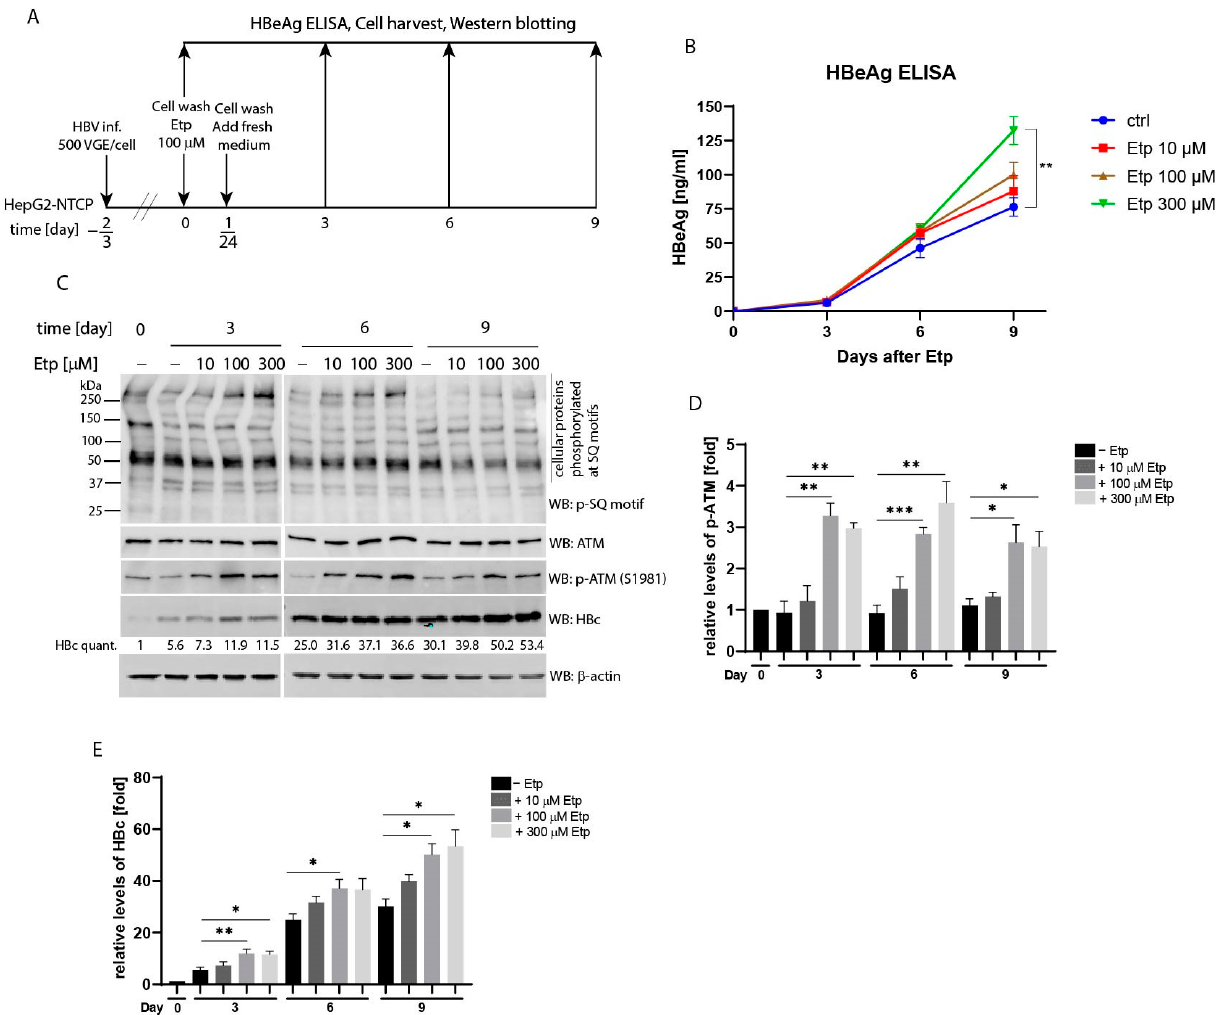
Figure 6. The stimulatory effect of etoposide treatment on the level of HBeAg and HBc is dose-dependent. ( A ) The experimental outline: HepG2-NTCP cells were infected with HBV (MOI 500 VGE per cell) and treated with 10, 100 or 300 μ M etoposide for 1 h, or left untreated ( − ). At various time-points (0, 3, 6 and 9 days) after addition of etoposide, the levels of HBeAg ( B ) in the culture supernatants were analyzed by an enzyme-linked immunosorbent assay (ELISA). Data is shown as mean ± standard deviation for three independent experiments. ** p < 0.01 obtained by a two-tailed paired t test, n = 3. ( C ) The protein lysates (20 μ g) isolated at different time-points were analyzed by Western blot using antibodies against a phospho-SQ motif (p-SQ), HBc, ATM, p-ATM and β -actin (loading control). The intensity of the HBc protein signal was quantified and normalized to the corresponding level of β -actin. The amount of the HBc protein in non-treated control cells at time-point of 0 day was set to 1. The HBc quant. values were calculated as mean of three independent infection experiments. ( D , E ) The statistical analyses of the ATM phosphorylation signal (p-ATM; shown in ( D )) and the HBc protein level (shown in ( E )) that were determined in ( C ) using Image Studio Lite Software for densitometric analysis. The data are shown as mean ± SD from three independent experiments. The asterisks indicate statistically significant differences between untreated controls (marked as − ) and Etp-treated groups determined by a two-tailed paired t test, * p < 0.05, ** p < 0.01, *** p < 0.001, n = 3.